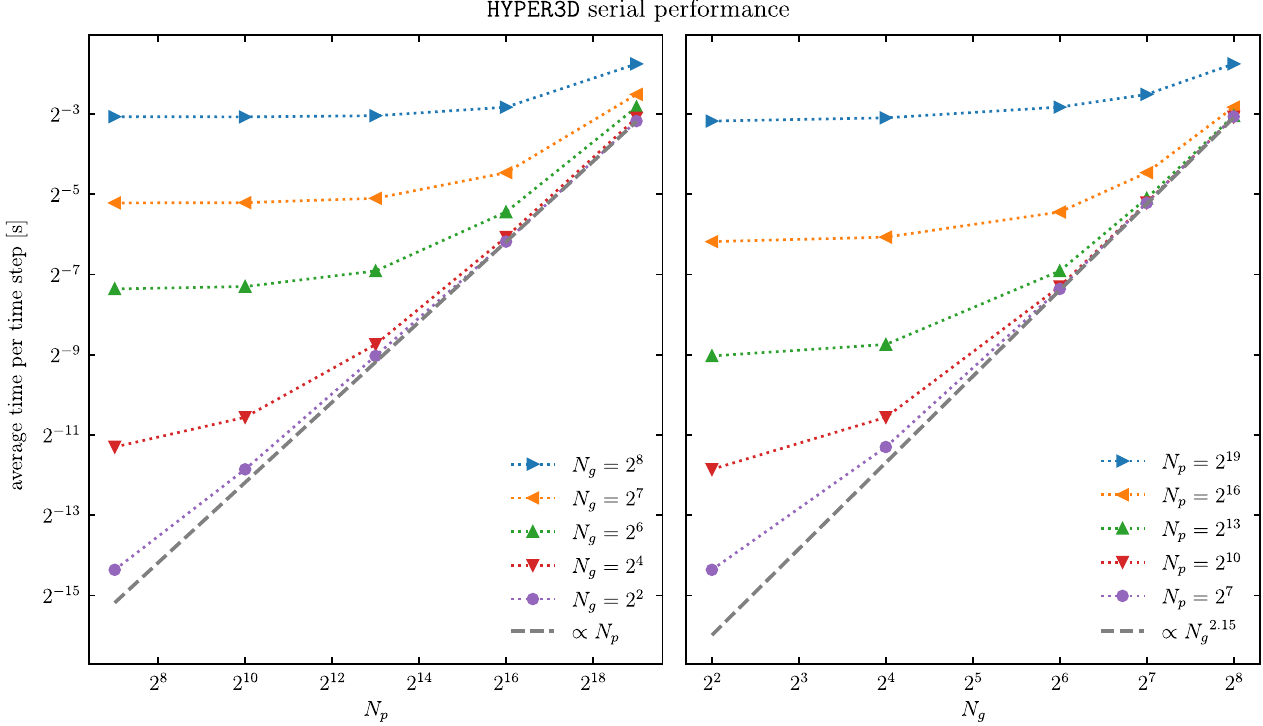
FIG. 5. The single-threaded performance of the HYPER 3 D code, measured as the average time in seconds per time step, for different numbers of grid points and macroparticles. The computation time scales linearly with the number of macroparticles and slightly more than quadratically with the number of grid